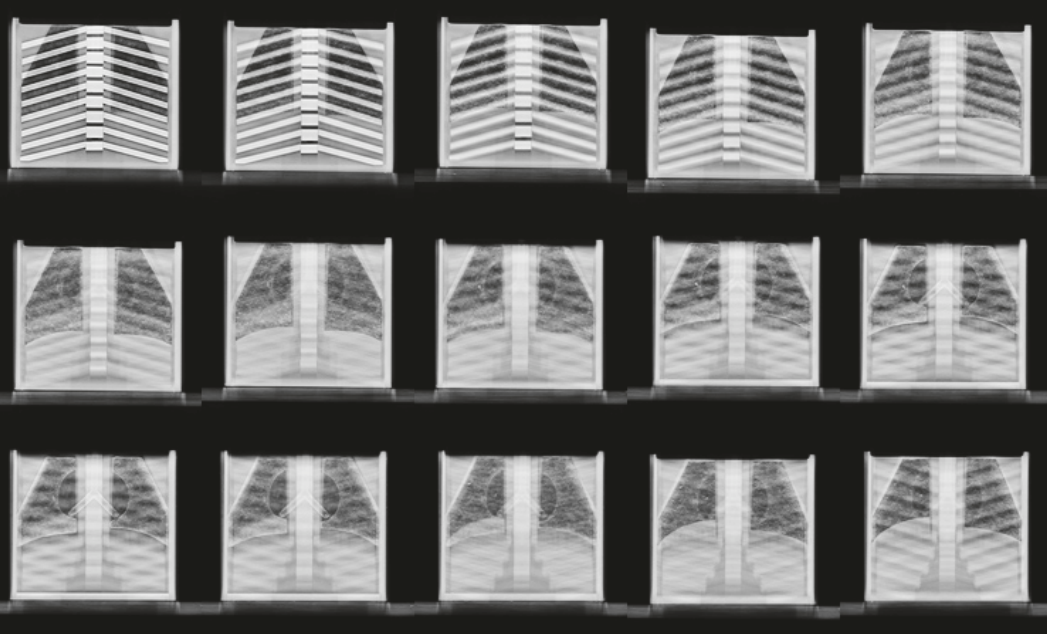
Figure 5: A montage of 12 reconstructed frames of the VolumeRAD acquisition for the first phantom. Notice how the airway bronchi are clearly visible in frames 10 through 12 (left to right, top to bottom).